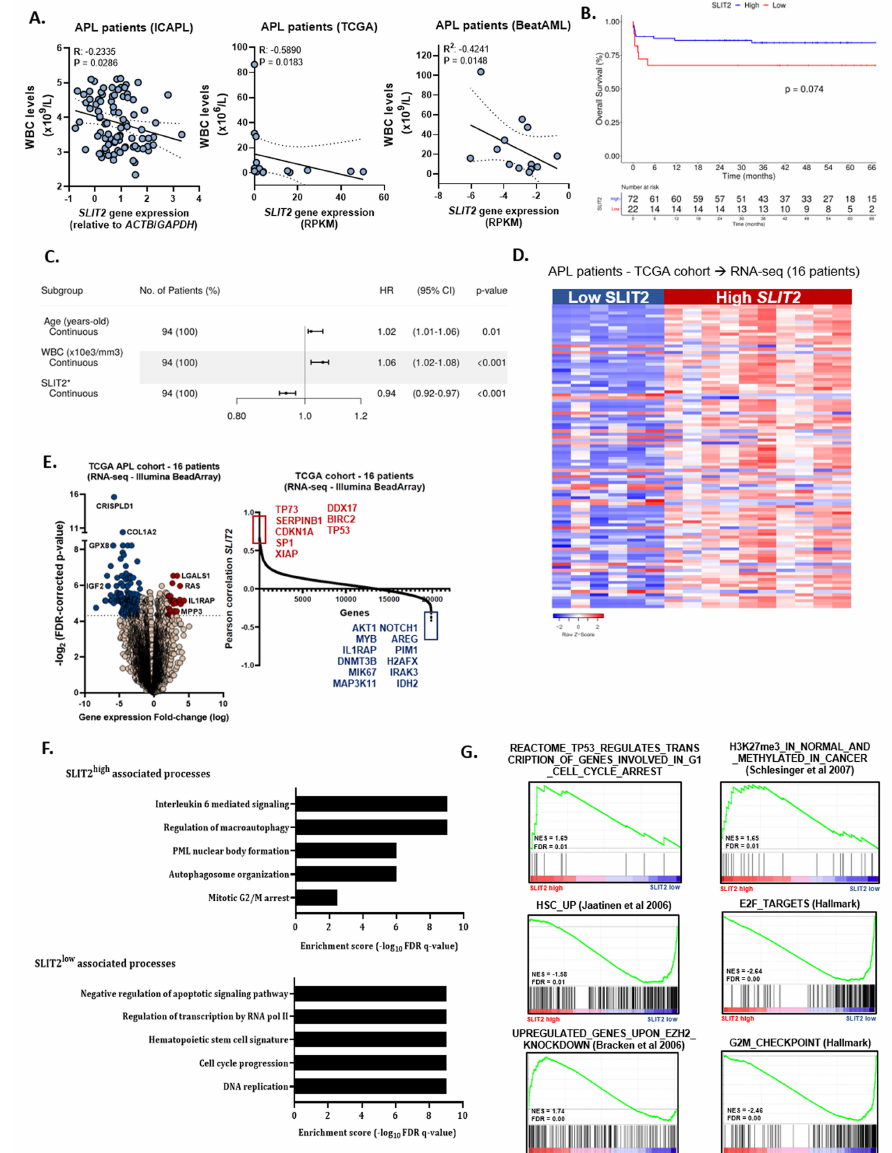
Figure 1. Clinical role of SLIT2 in acute promyelocytic leukemia (APL). ( A ) Correlation analysis of SLIT2 expression and white blood cell count in APL patients included in the International Consortium of Acute Promyelocytic Leukemia (IC-APL) cohort (left panel), in the TCGA cohort (middle panel) and in the BeatAML study (right panel). The r and p -values are indicated on the figure, Spearman correlation test. ( B ) The probability of overall survival in APL patients according to the SLIT2 expression. Survival curves were estimated using the Kaplan–Meier method and the log-rank test was used for comparison. ( C ) Multivariate Cox model for overall survival. Differential expression of SLIT2 can categorize APL patients into different risk groups. ( D ) Heatmap of differentially expressed genes (supervised clustering) in APL samples from TCGA cohort dichotomized based on the SLIT2 gene expression (dichotomization point: expression below 1; groups: high ( n = 10) and low ( n = 6) expression). ( E ) Volcano plot comparing APL patients with low SLIT2 expression versus APL patients with high SLIT2 . Fold change was set at 2 for upregulated and downregulated gene expression. Significance was set at a corrected FDR < 0.05. A total of 232 genes were downregulated (blue) and 108 were upregulated (red). ( F ) Gene ontology (GO) and ( G ) gene set enrichment analysis (GSEA) on a ranked gene list based on the leading-edge genes for SLIT2 expression in 16 de novo APL patient samples from TCGA study. Genes were ranked based on Pearson correlation using the SLIT2 gene expression. Normalized enrichment score (NES) and false discovery rate (FDR) was used to determine